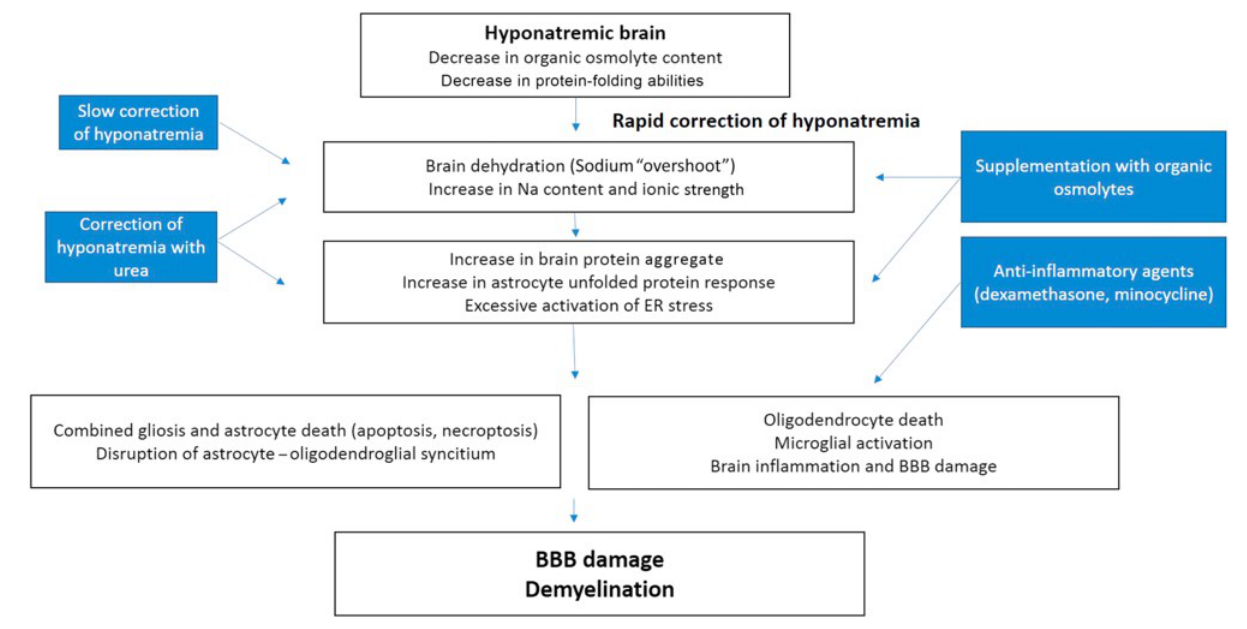
Figure 2. Proposed model for the physiopathology of osmotic demyelination syndrome. Reproduced from [9]: Gankam et al.: Kidney International Reports, 2017 with permission. BBB: blood–brain barrier, ER: endoplasmic